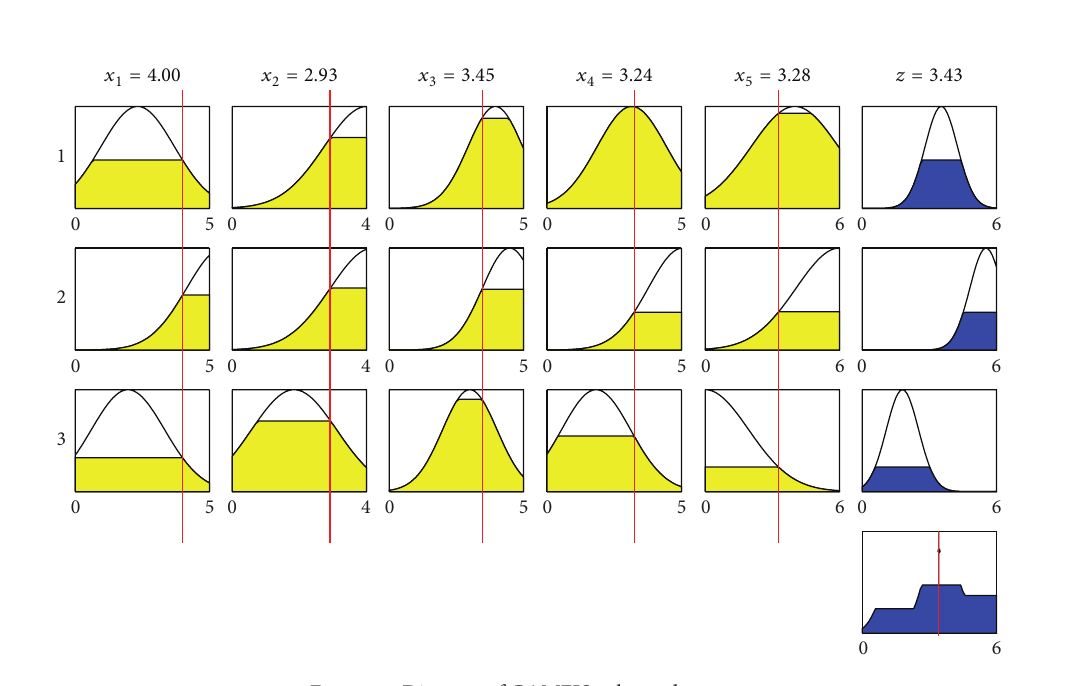
Figure 5: Diagram of GAMFIS rules and output.